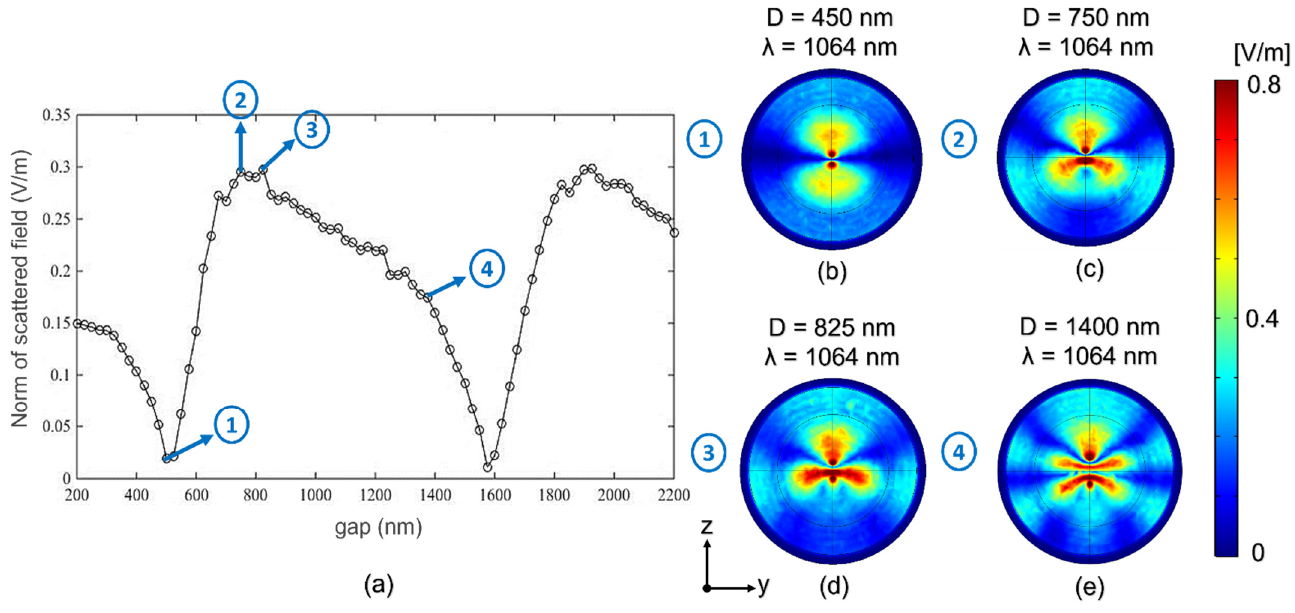
Figure 3. ( a ) Norm of the scattered field versus distance between nanocylinders for an incident wavelength λ = 1064 nm. Scattered field patterns at ( b ) D = 450 nm. ( c ) D = 750 nm. ( d ) D = 825 nm. ( e ) D = 1400 nm.